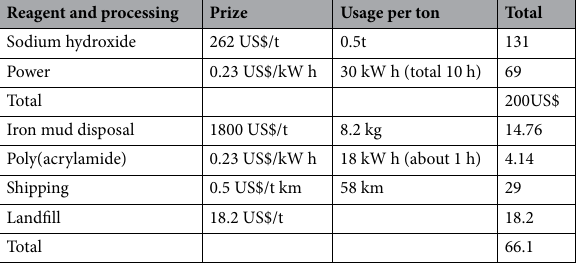
Table 5. Operation cost of 1 ton magnetic adsorbent for OTC